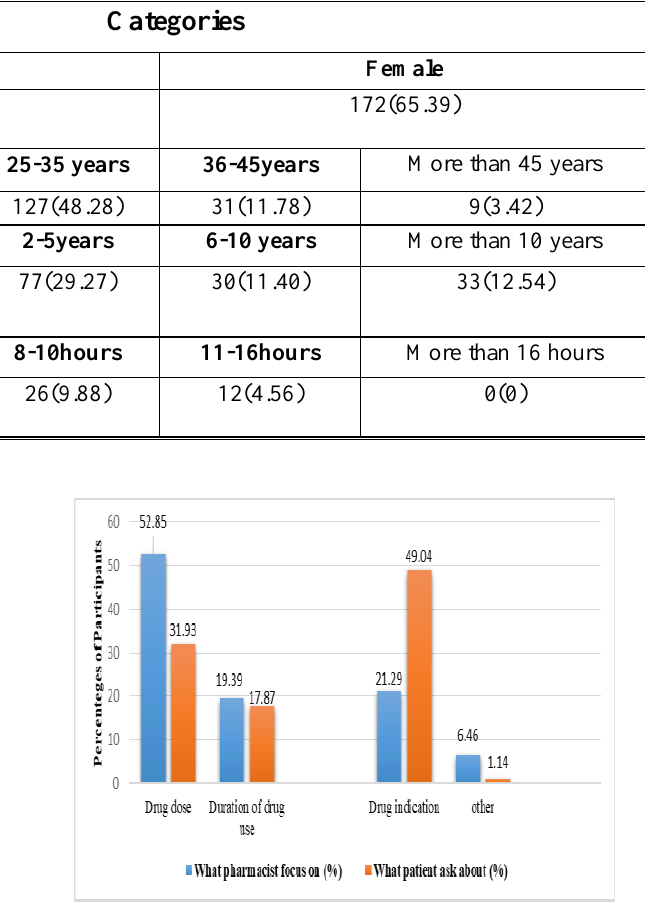
Figure 1.Variance in motivation about the consultation between pharmacists and patients as pharmacists stated (n=263).